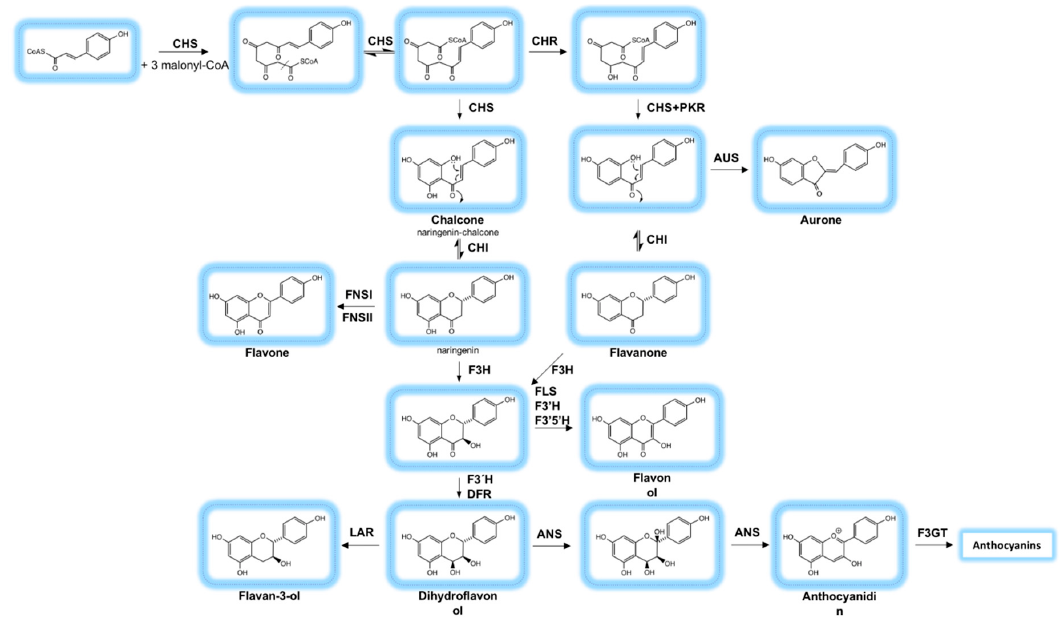
Figure 4. Biosynthesis of flavonoids via the flavonoid pathway. A detailed description can be found